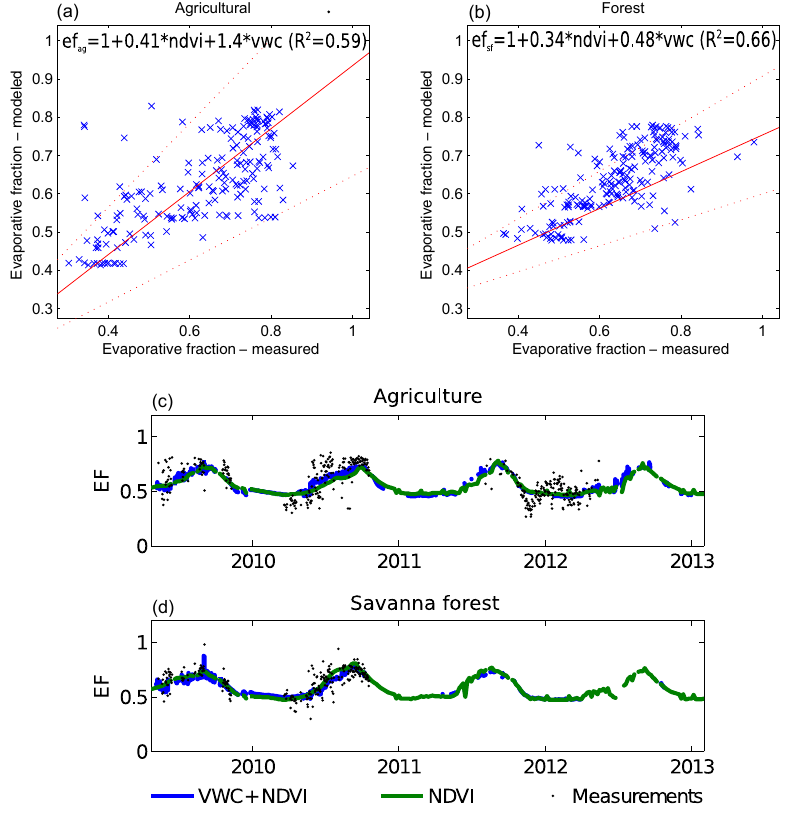
Figure 9. Further examination of relationship between soil moisture, vegetation index, and evaporative fraction. Panels (a, b) show the quality of fit of the linear regression model relating soil volumetric water content, vegetation index, and evaporative fraction over agriculture (a) and over the savanna forest (b) . The 1:1 line is in red and the 95% confidence interval is shown with dotted lines for the range of available soil and vegetation. Evaporative fraction over the field (b) and the savanna forest (d) are shown. Measured data points are in black (points), calculated evaporative fraction based on soil moisture and NDVI are shown in blue, and NDVI alone is shown in